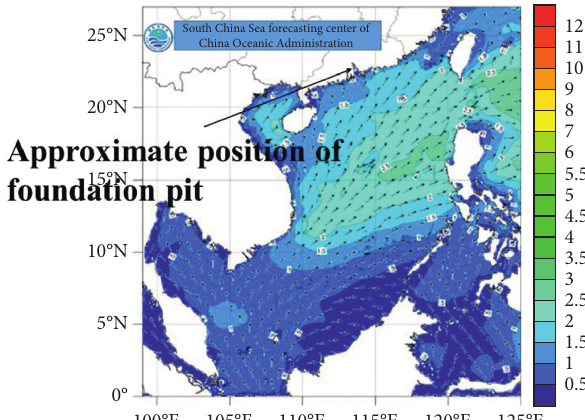
Figure 6: Wave height map of the South China Sea (unit: m).